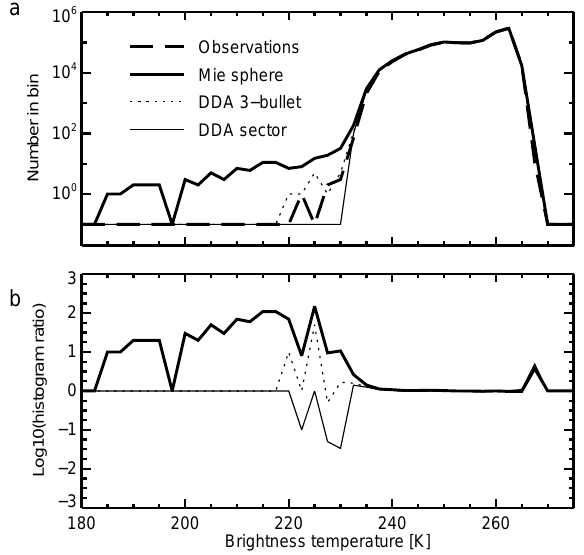
Figure 5. How the measure of histogram fit is constructed, using the 52.8GHz channel on SSMIS as an example. (a) Histograms of observed and simulated brightness temperature [K] using different scattering models. Bin size is 2.5K; Empty bins have been filled with the value 0.1. (b) Log of the ratio of histograms (simulation divided by